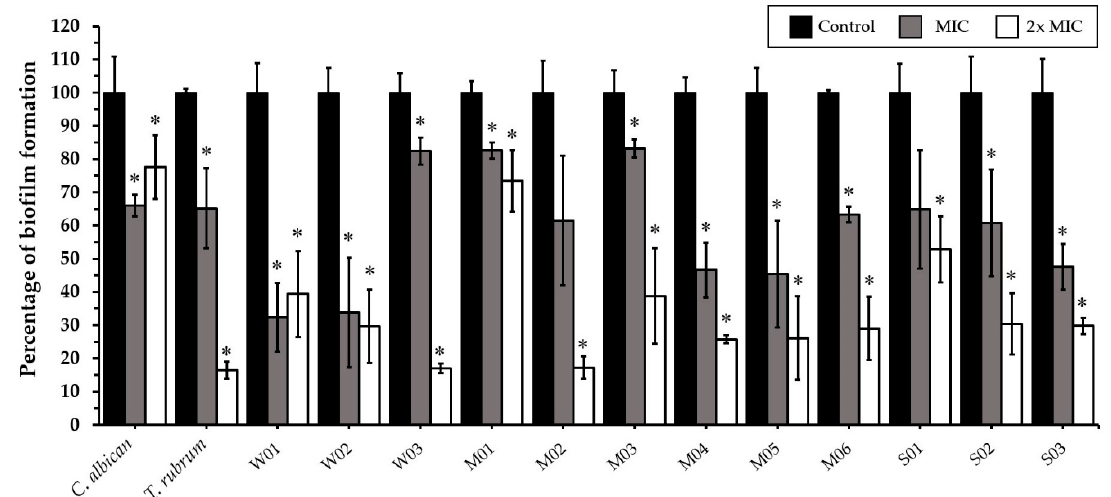
Figure 4. Effects of Coleus amboinicus ethanolic extracts on the biofilm formation of Candida albicans ATCC 90028, Trichophyton rubrum, and Microsporum canis after 96 h of treatment. Each bar represents the mean ± SD of three experiments per group. *differences between the control and treatments were statistically significant ( p < 0.05).